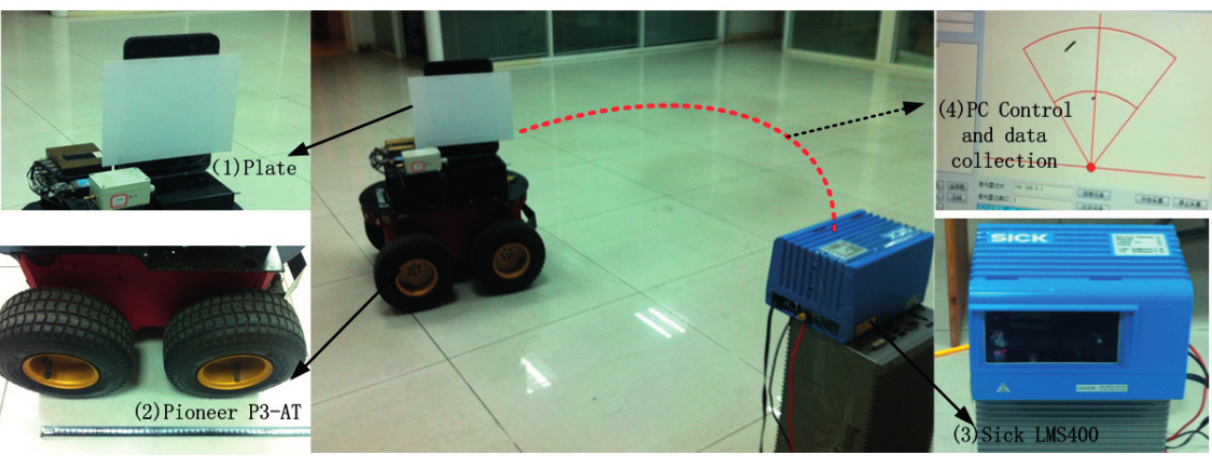
Figure 7. An overview of the proposed localization method based on a Laser Scanner. ( 1 ) The thin plate; ( 2 ) Pioneer P3-AT robot; ( 3 ) Sick LMS400 Laser Scanner; ( 4 ) Laptop software panel.